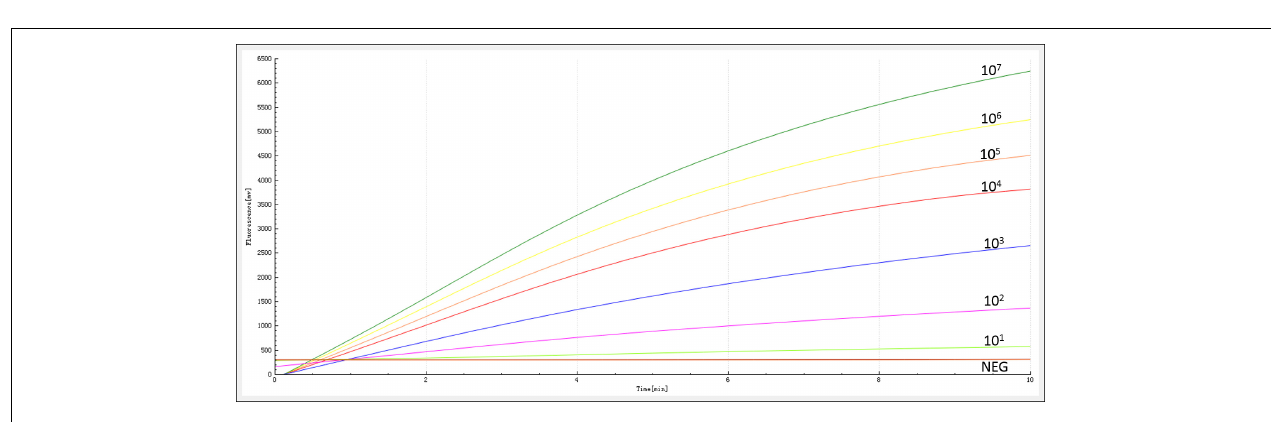
FIGURE 2 | Specificity of the RAA assay. Klebsiella pneumoniae 2146, Acinetobacter baumannii 1 and Pseudomonas aeruginosa produced amplification signals, while the other bla NDM -lacking bacterial types were negative (A–C) . All the bacterial types produced 16S rRNA gene amplification signals (D–F) . 1: K. oxytoca , 2: A. baumannii 2 , 3: K. pneumoniae 700603, 4: P. aeruginosa ATCC27853, 5: S. sonnei , 6: E. coli 25922, 7: C. jejuni , 8: E. aerogenes , 9: P. mirabilis , 10: S. enteritidis , 11: E. cloacae , 12: C. freundii , 13: P. mirabilis.